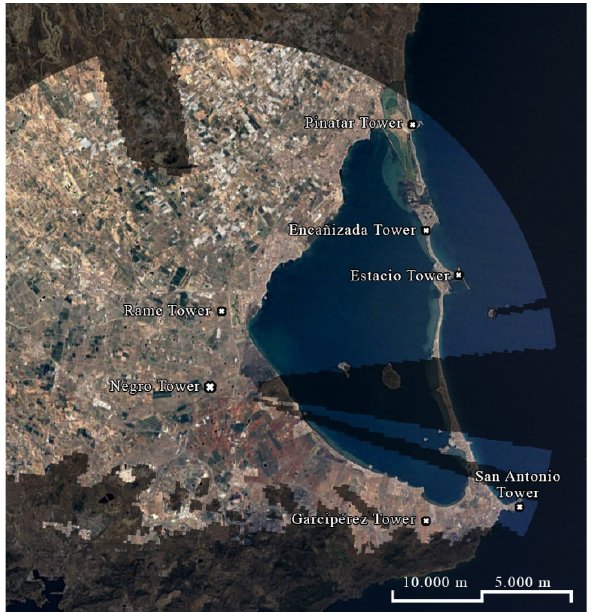
Figure 6. Image from the visibility study among coastal towers and fortress towers with the Negro Tower as the